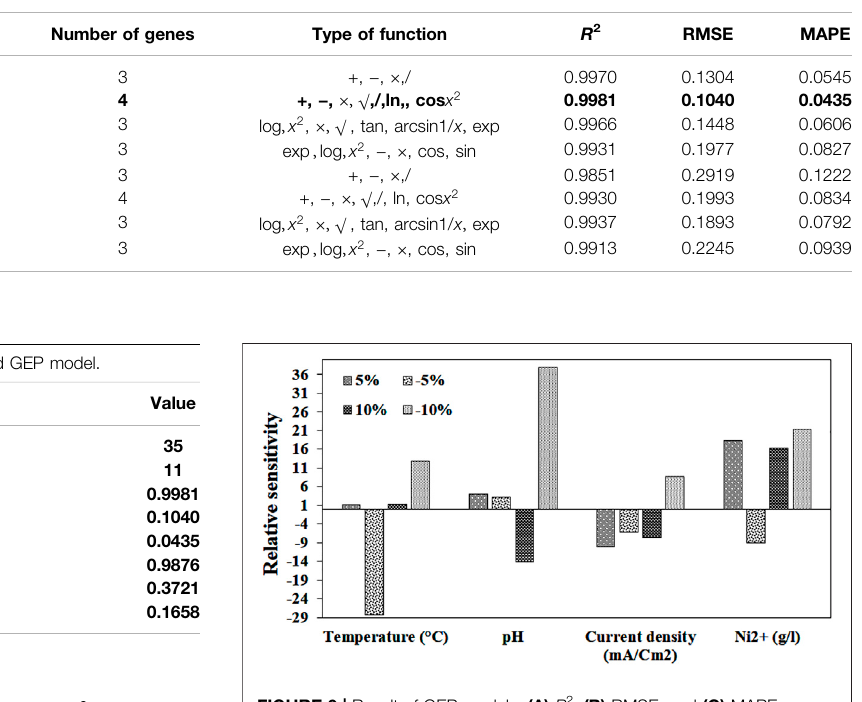
TABLE 6 | Statistics of GEP models.